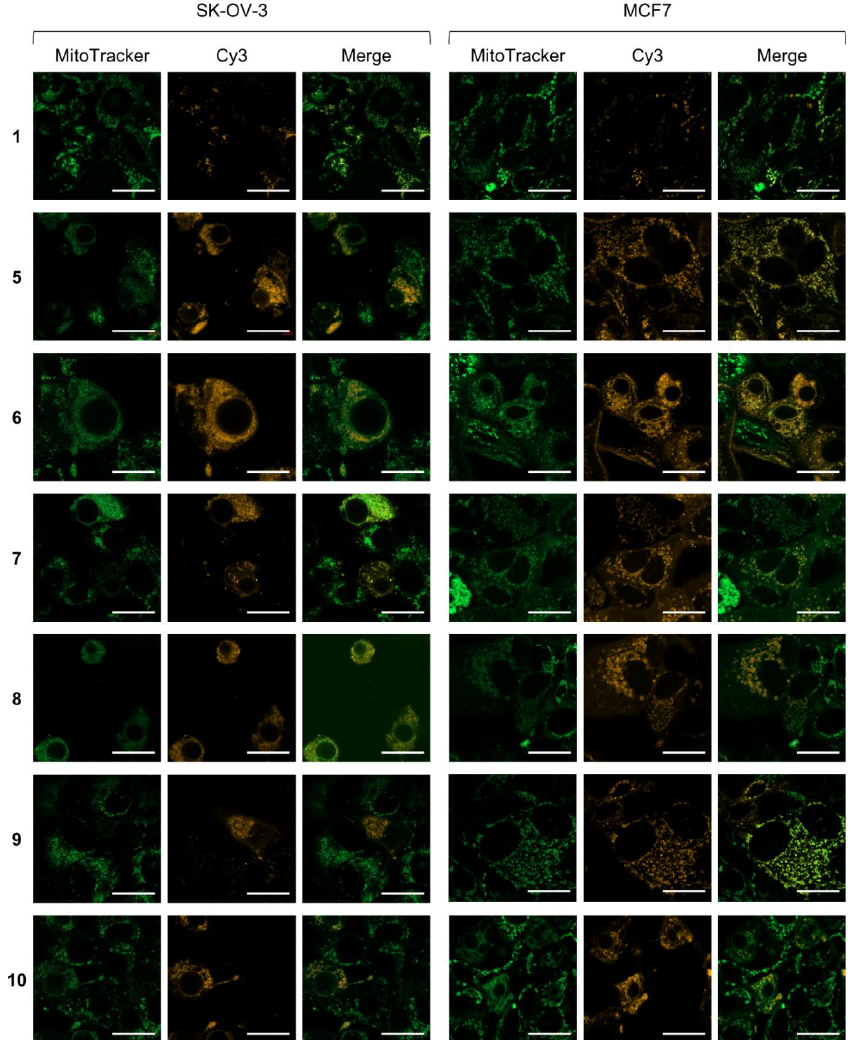
Figure 3. Confocal microscopy images of SK-OV-3 and MCF7 cells treated with Cy3-containing conjugates. Cells were treated with 10 µ M of the indicated conjugate for 10 min at 37 ◦ C, washed, stained with 50 nM MitoTracker Green FM and 10 µ g/mL Hoechst33258 for 10 min at 37 ◦ C, washed, and imaged at 63X. Pearson’s correlation coefficients of MitoTracker Green FM and Cy3 fluorescence for compounds 1 , 5 , 6 , 7 , 8 , 9 , and 10 in SK-OV-3 and MCF cells are 0.75/0.64, 0.73/0.81, 0.91/0.61, 0.78/0.63, 0.85/0.69, 0.43/0.82, and 0.78/0.60, respectively. Excitation wavelengths for Hoechst33258, MitoTracker Green FM and Cy3 were set as 405, 488, and 561 nm, respectively. Scale bars denote 25 µ m. Additional images, including the results of Hoechst33258 staining, are shown in Figure S4 (SK-OV-3 at 20X), Figure S5 (SK-OV-3 at 63X), Figure S6 (MCF7 at 20X) and Figure S7 (MCF7 at 63X), Supplementary